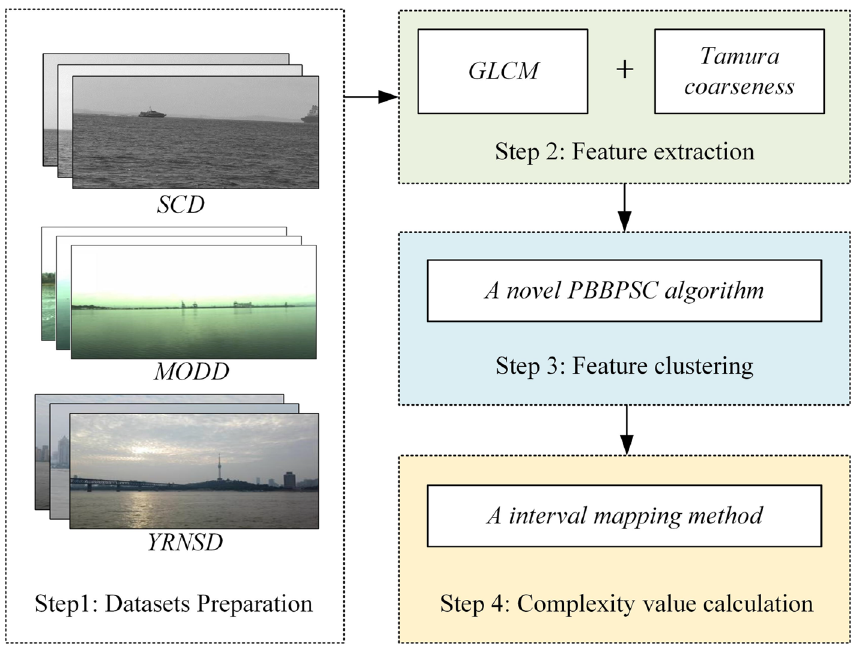
Figure 3. The framework of the complexity perception